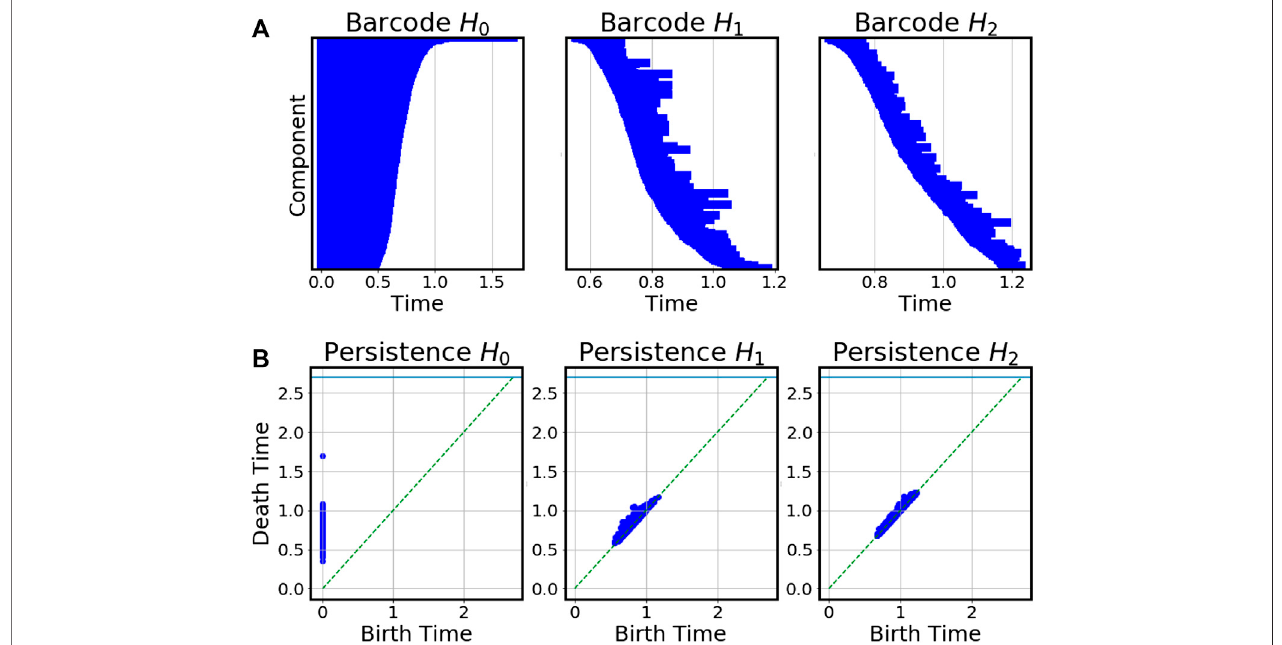
FIGURE5 | (A) Barcodes in 0, 1, and 2 dimensions. Each bar represent a generator of the homology group, i.e. H { p , q } n ( Σ ) , where {p, q} marksa lifetime, the rank of H { p , q } n ( Σ ) equals Betti number of homology groups in the n th dimension, the length of {p, q} signi fi es the persistence of the n th Betti number. (B) The barcodes can be convertedintopersistence diagrams,whereoneofthebarsin (A) isequivalenttoonepointinthepersistence diagram. Thelifetimeofeachbarin (A) canbetransformed into a perpendicular distance concerning the diagonal lines in (B) . If A point that is farther away from the diagonal line implies a more persistent topological feature, whereasapointthatisclosertothediagonallinerepresentsalesspersistentfeature.Wefoundthatthebarcodesareratherrobustanddonotshow fl uctuationsoncethe dataset is fi xed, thus we do not include error bars in all barcodes appearing in this paper.